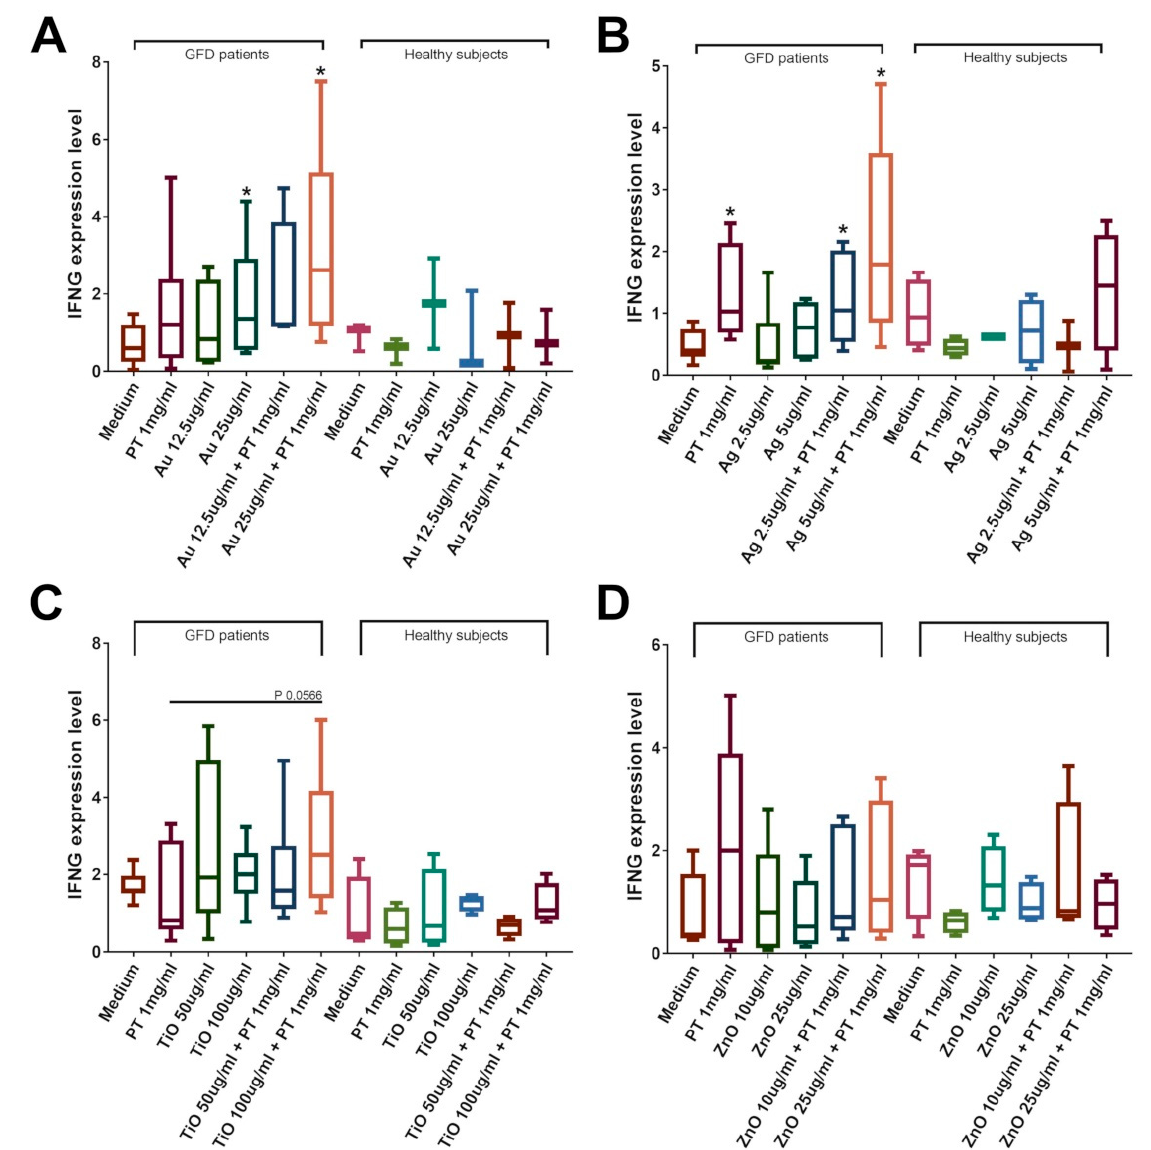
Figure 8. IFNG expression in CeD patients on a GFD and healthy controls. Significance versus untreated biopsies is indicated above each column (* p < 0.05), whereas versus PT is represented by bars. Duodenal biopsies stimulated 4 h with PT 1 mg/mL ± ( A ) AuNPs 12.5/25 µ g/mL (GFD n = 6; Healthy n = 3); ( B ) AgNPs 2.5/5 µ g/mL (GFD n = 6; Healthy n = 4); ( C ) TiO2NPs 50/100 µ g/mL (GFD n = 7; Healthy n = 4); ( D ) ZnONPs 10/25 µ g/mL (GFD n = 5; Healthy n = 4). Box plots represent median, 25th, and 75th percentiles. Whiskers indicate 5th and 95th percentiles.